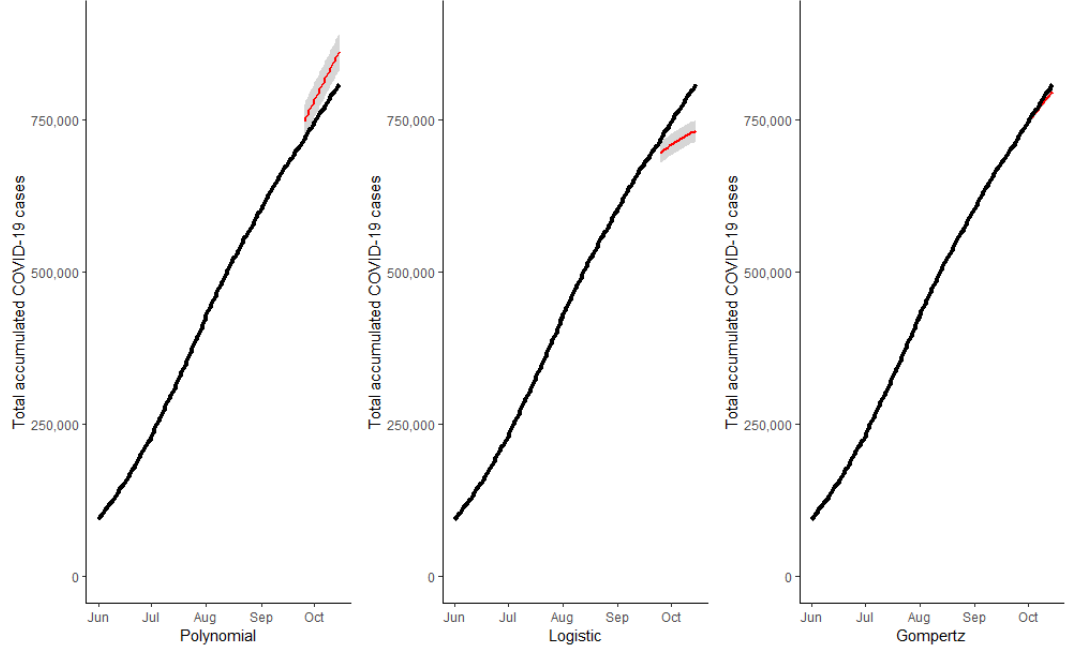
Figure 7. Forecast for total accumulated cases at 21 days at the national level in Mexico. Table 4. Root mean square error (RMSE) values for the four case studies for three different models examined.